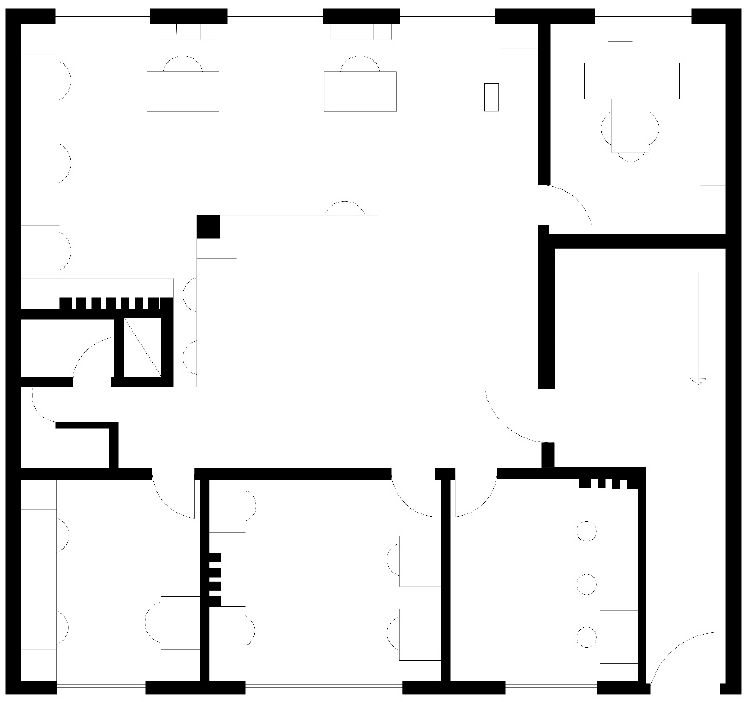
Figure 5. Simulated office building and office room plan.